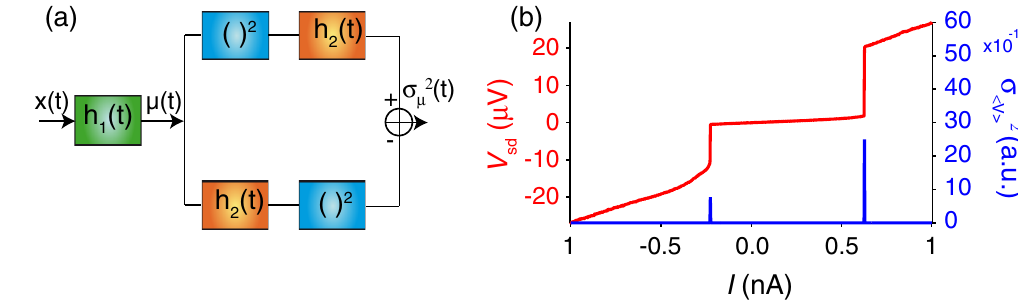
FIG. 10. Digital filter for switching-current detection. (a) Schematic view of the implemented filter based on the work of Liu et al. [31]. The first-order moment (cid:6) ð t Þ of the signal x ð t Þ in a sliding window is obtained through the filter h 1 ð t Þ ¼ Rect ð t=L 1 Þ =L 1 , where Rect ð t Þ is the normalized rectangular function and L h (cid:6) ð t Þ 2 i - h (cid:6) ð t Þi 2 in a sliding window with h first-order moment obtained by the implemented digital